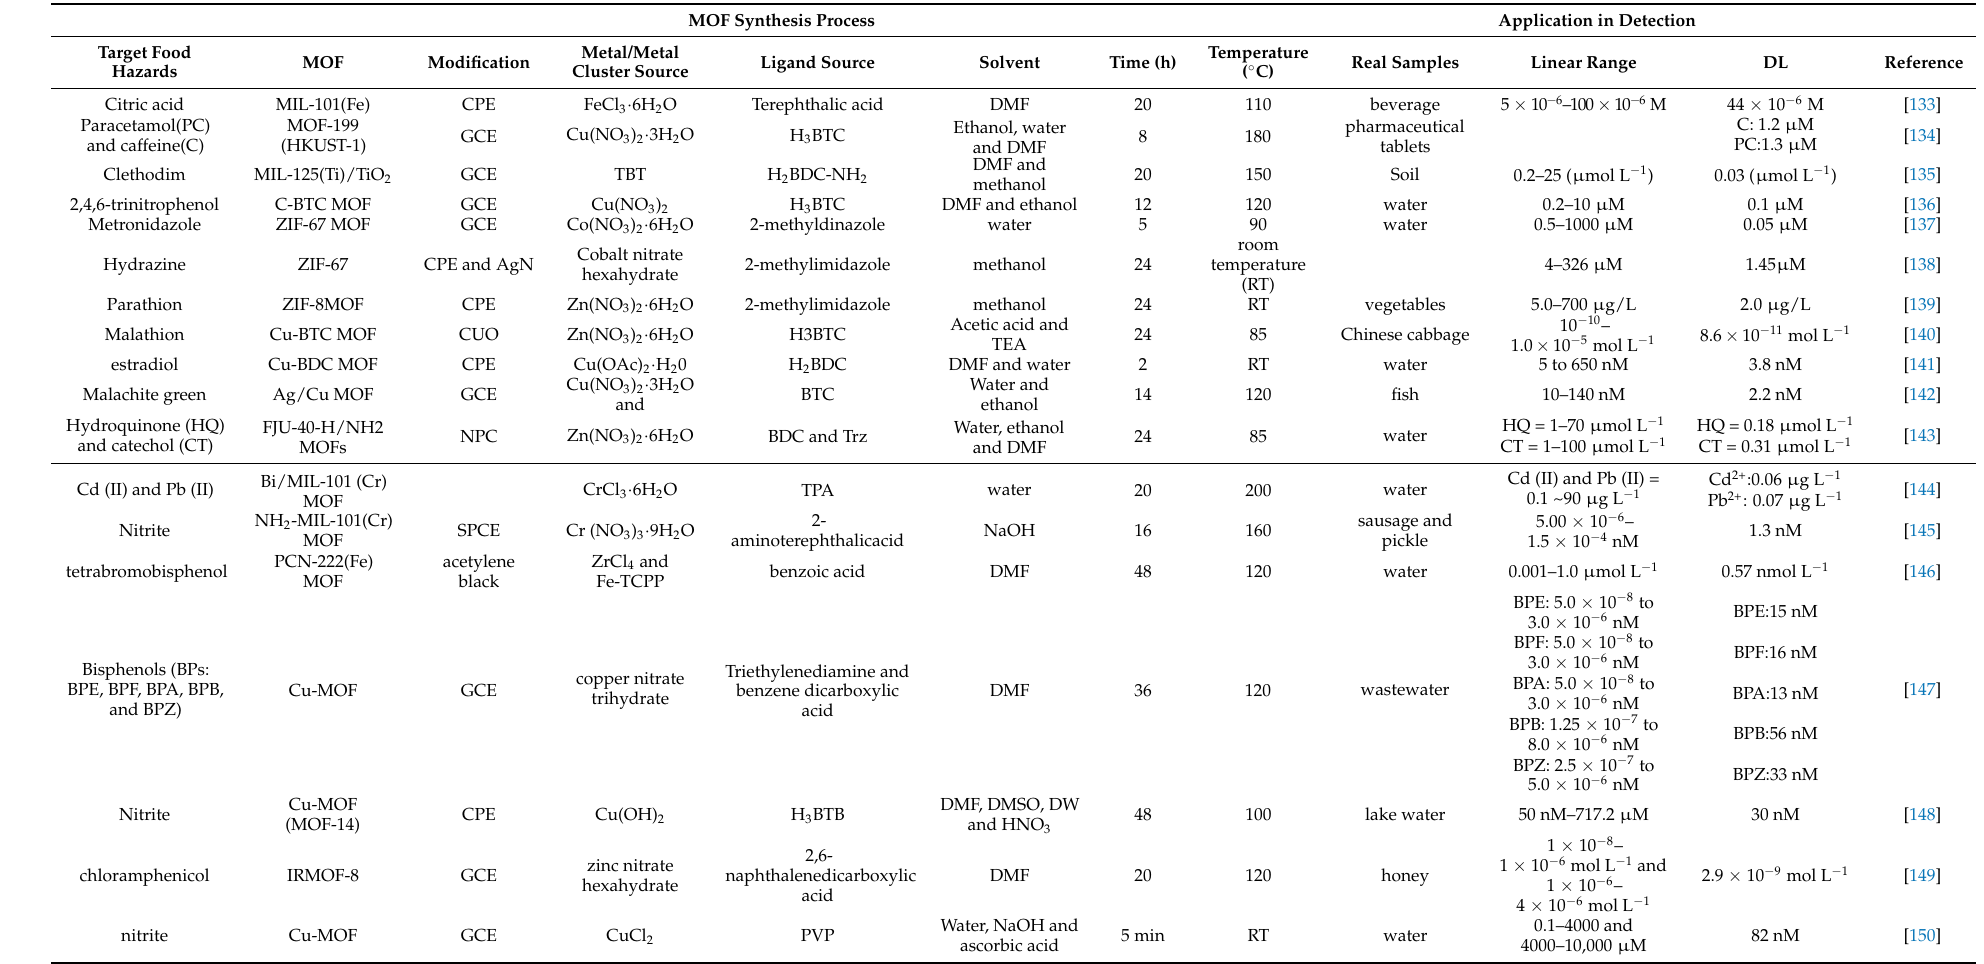
Table 2. Sensing application of MOF-based Electrochemical Sensing for food safety